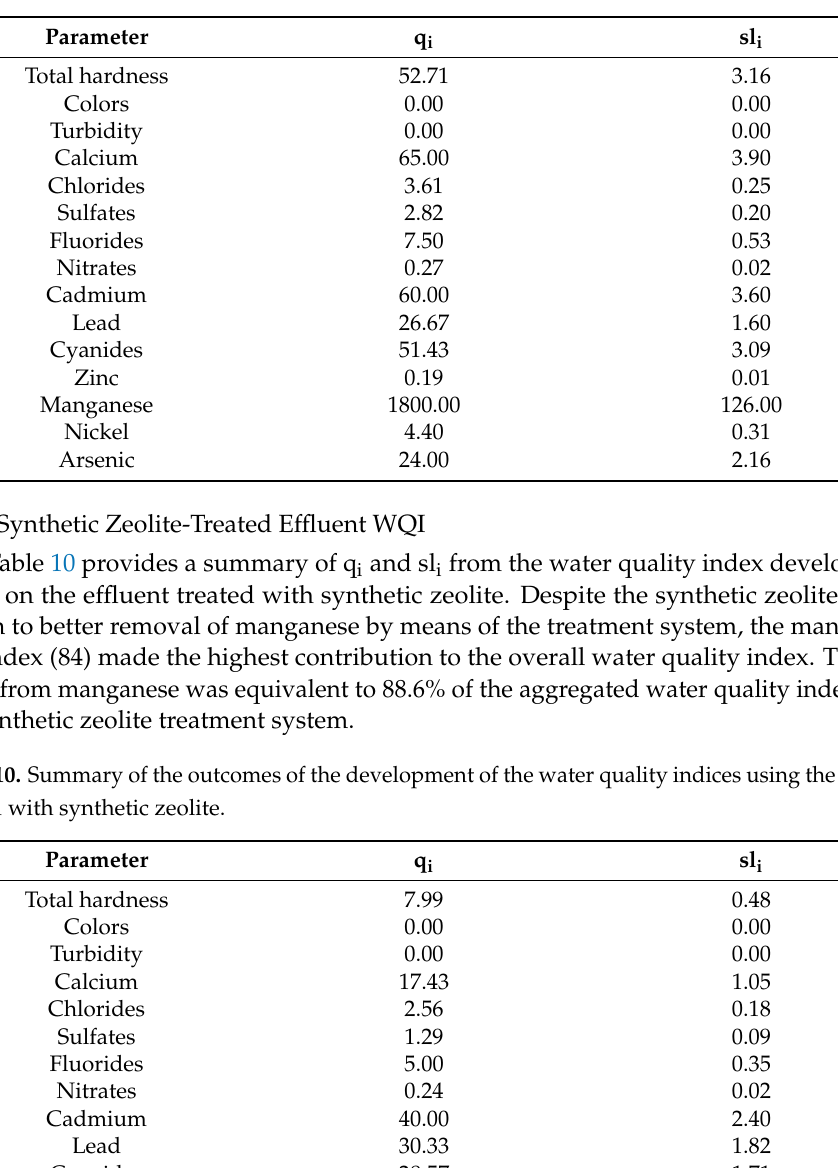
Table 9. Summary of the outcomes of the development of the water quality indices using the effluent treated with natural zeolite.